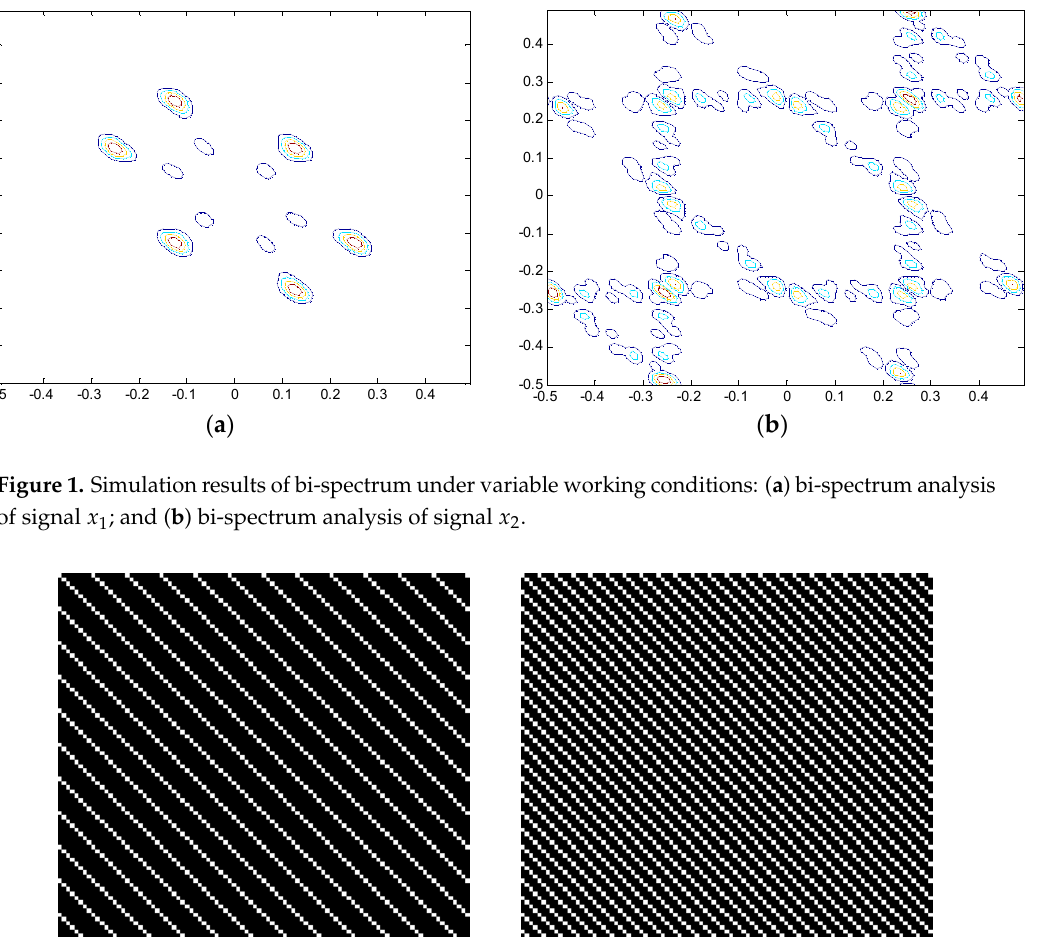
Figure 2. Simulation results of recurrence plot under variable working conditions: ( a ) Recurrence plot analysis of signal x 1 ; and ( b ) Recurrence plot analysis of signal x 2